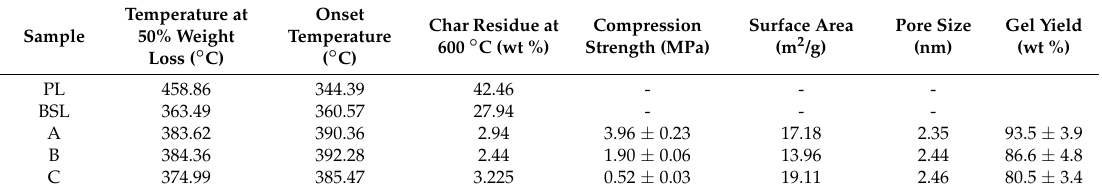
Table 3. Thermal properties, compression strength, surface area, and pore size of samples.